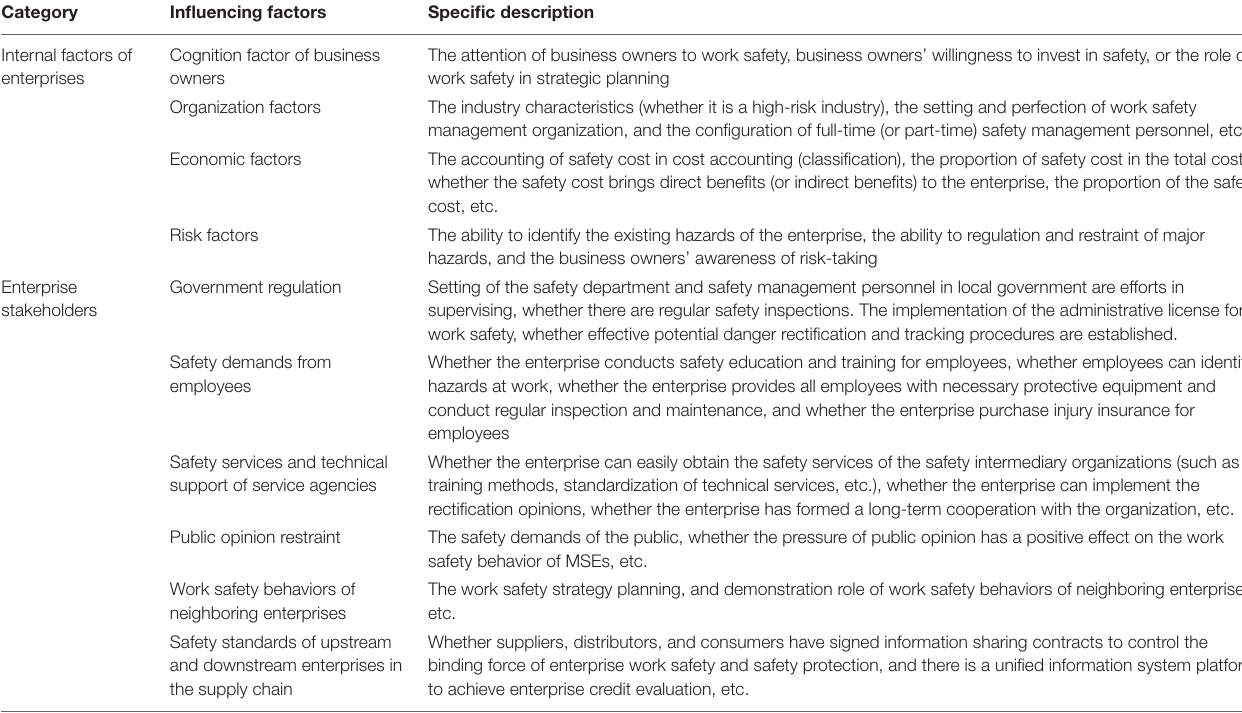
TABLE 1 | Classification of influencing factors of work safety behavior of micro and small enterprises (MSEs).